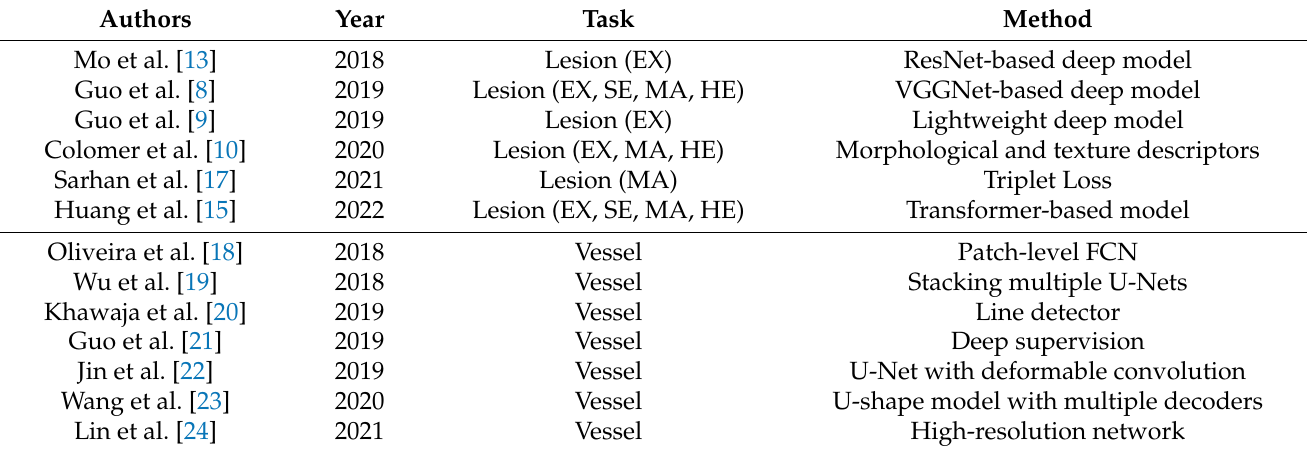
Table 1. Summary of related works (EX, SE, MA, and HE represent hard exudate, soft exudate, microaneurysms, and hemorrhage,